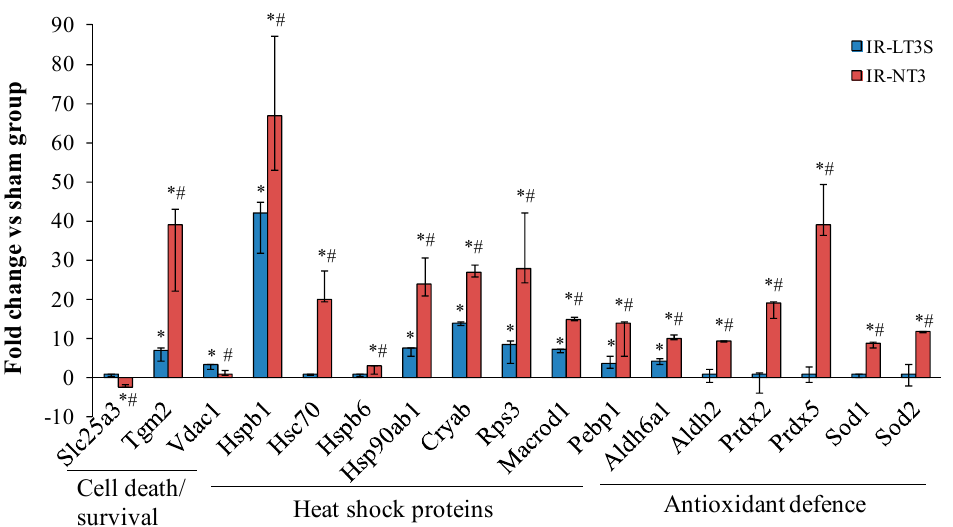
Figure 3. Differentially expressed proteins involved in cell death and mitochondrial quality control in response to stress. Data are expressed as median and interquartile range. * p vs. sham < 0.017; # p vs. IR-LT3S < 0.017. Protein acronyms are listed in the abbreviation list.